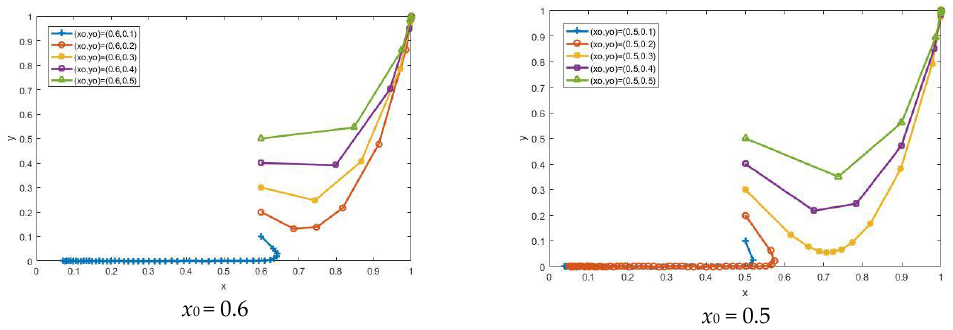
Figure 4. The impact of changes in y 0 on the evolutionary result.